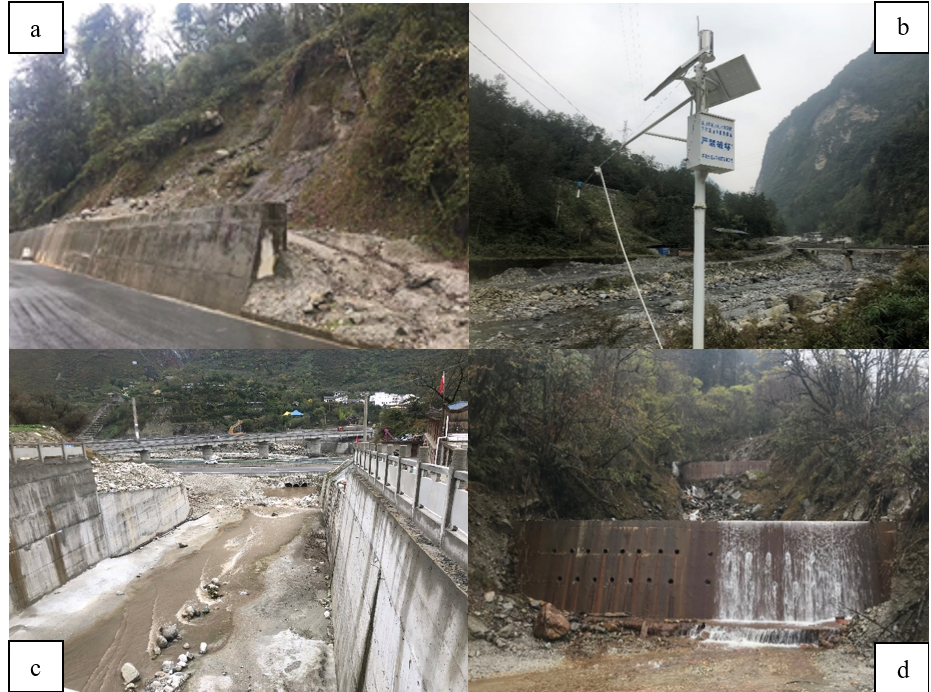
Figure 4. Structural engineering measures to prevent and control: (a) gravity retaining wall, (b) debris flow pre-warning device, (c) discharge chute for debris flow, (d) permeable type of retaining dam for debris flow.